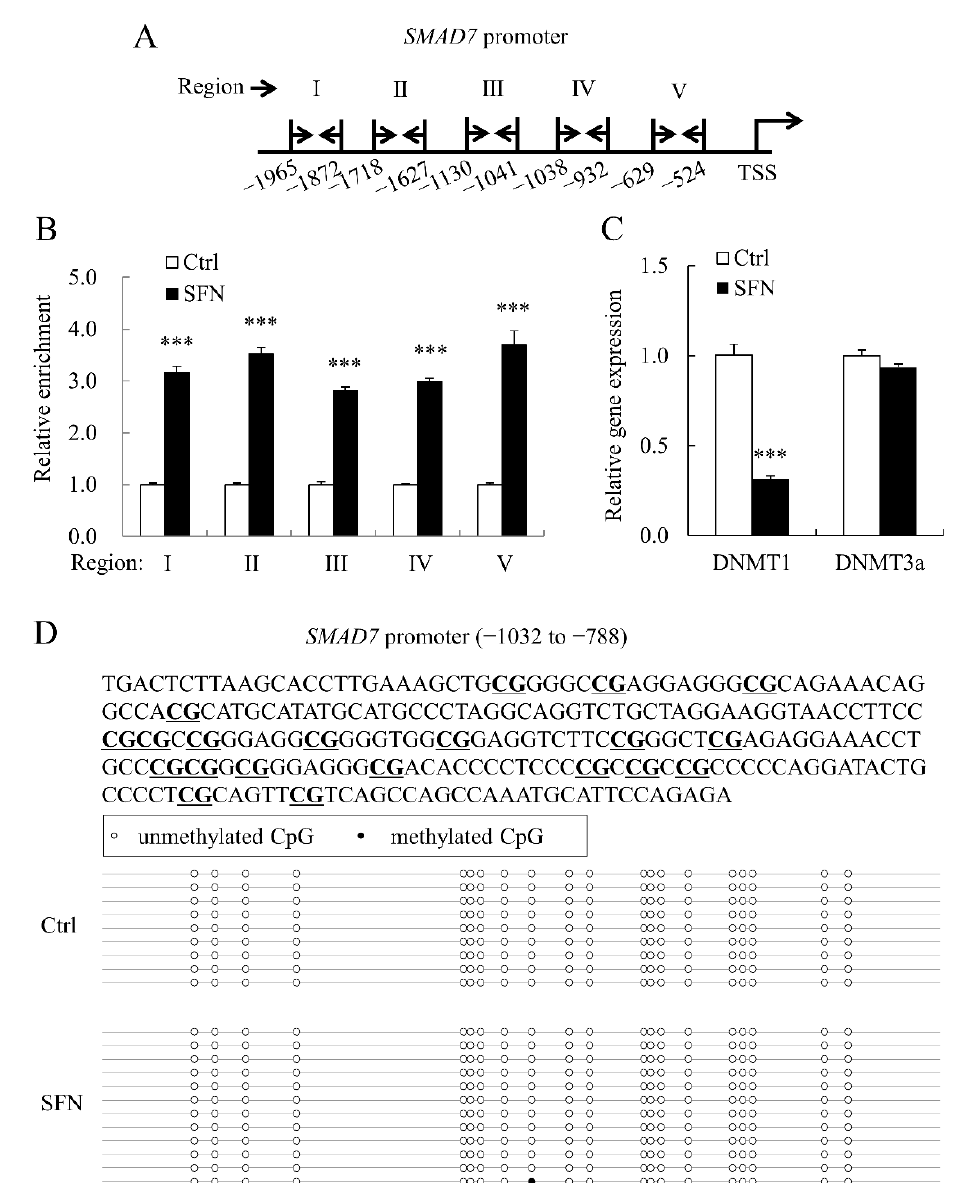
Figure 6. Histone H4 acetylation in porcine SMAD7 promoter was enriched by SFN. ( A ): The schematic map shows the locations of primer sets (forward primer: right arrow and reverse primer: left arrow) used in ChIP-qPCR; ( B ): Relative enrichment fold change of histone H4 acetylation of five regions across porcine SMAD7 promoter; ( C ): DNMT1 and DNMT3a relative mRNA expression levels in Ctrl and SFN groups; ( D ): The methylation status of CpG island ( − 1032 to − 788 bp) in the SMAD7 promoter. CpG sites are highlighted with underline in the upper panel. Data are shown as the mean ± SE and assays were done in triplicates. *** p < 0.001.